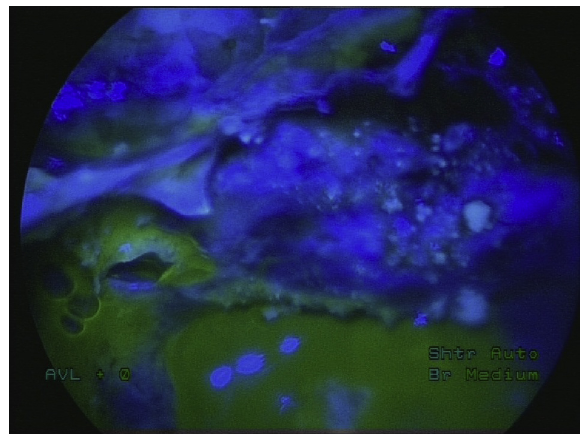
Figure 2 Fluorescein-stained cerebrospinal fluid fistula with a CSF leak, with a blue light filter.